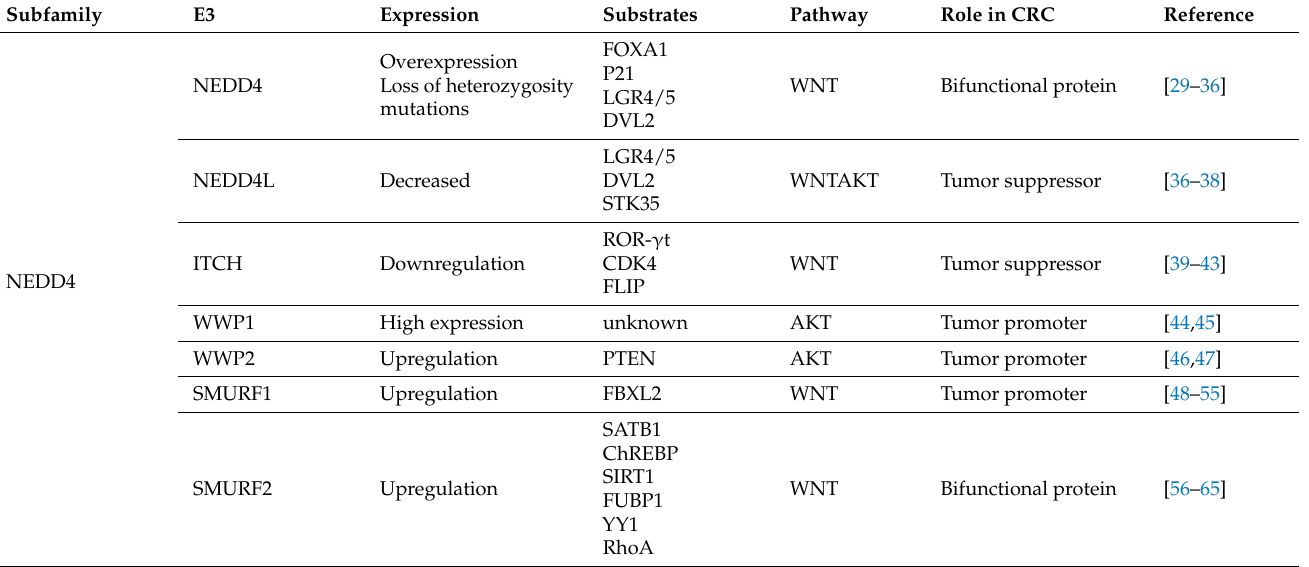
Table 1. HECT E3 ligases in human colorectal